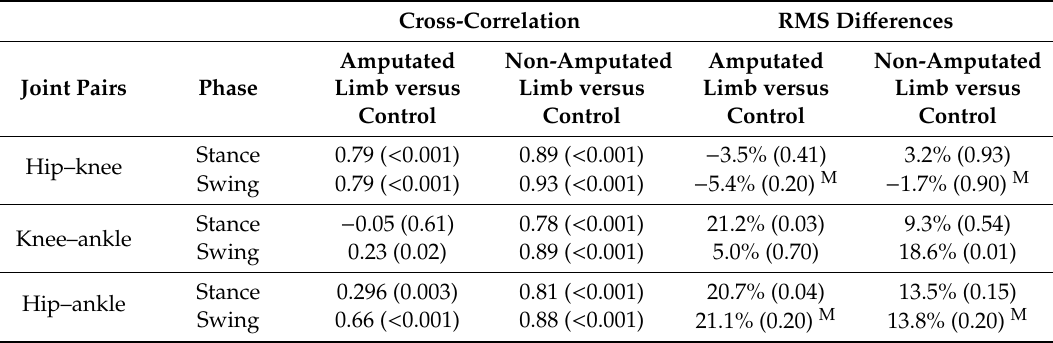
Table 3. Cross-correlation coe ffi cients and root-mean-square (RMS) di ff erences between the amputees and able-bodied